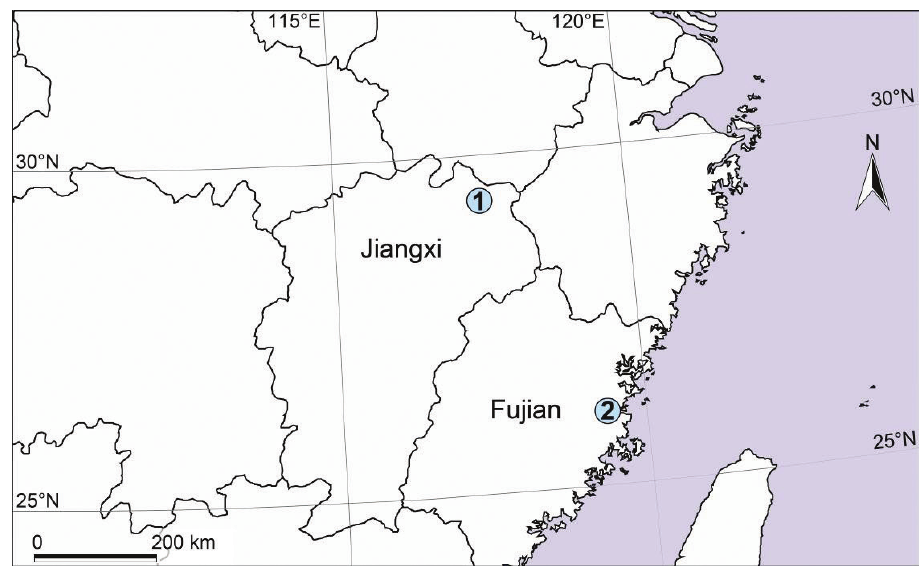
Figure 6. Collecting localities of two Longicoelotes species from China. 1 . L. geei sp. n., 2 . L. kulianganus .